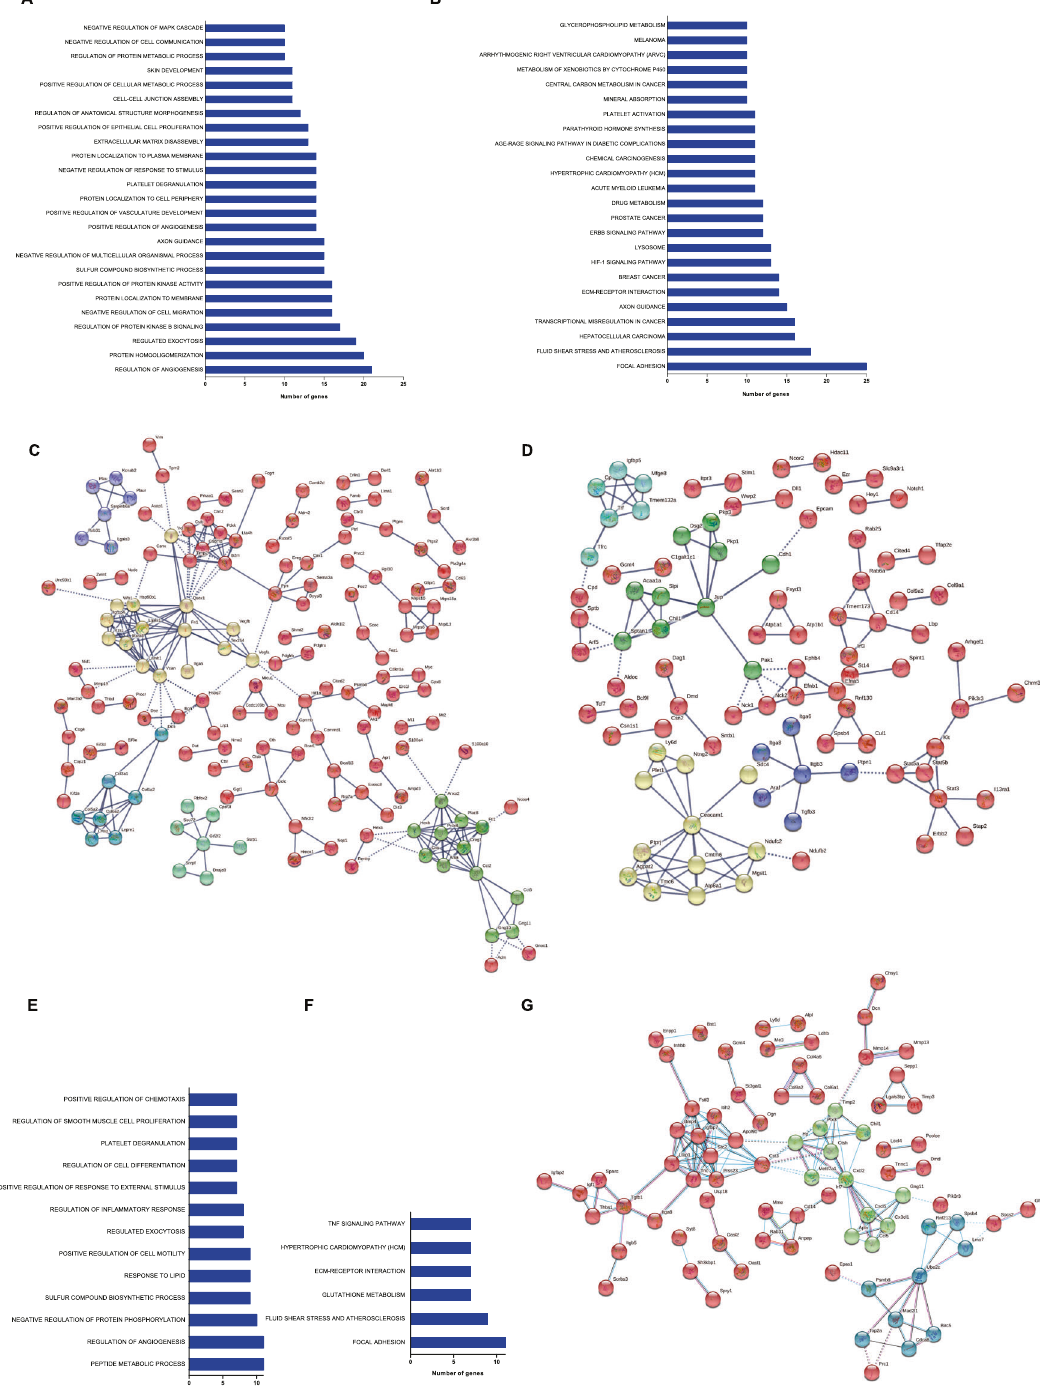
Fig. 6 Differentially expressed genes in HER2-positive and HER2-negative cell lines A – D and in MamBo89HER2 stable versus MamBo43HER2 labile cells E – G . A , E Biological processes and B , F KEGG pathways with adjusted p -value<0.05, gathering genes >10 and excluding biological processes and pathways with a number of genes >200. C , D Representation of protein-protein interactions among HER2-negative up- regulated C and down-regulated D gene products (STRING, interaction con fi dence level 0.9, K-means cluster 5). G Representation of protein- protein interactions among MamBo89HER2 stable versus MamBo43HER2 labile differentially expressed genes ( STRING, interaction con fi dence level 0.9, K-means cluster